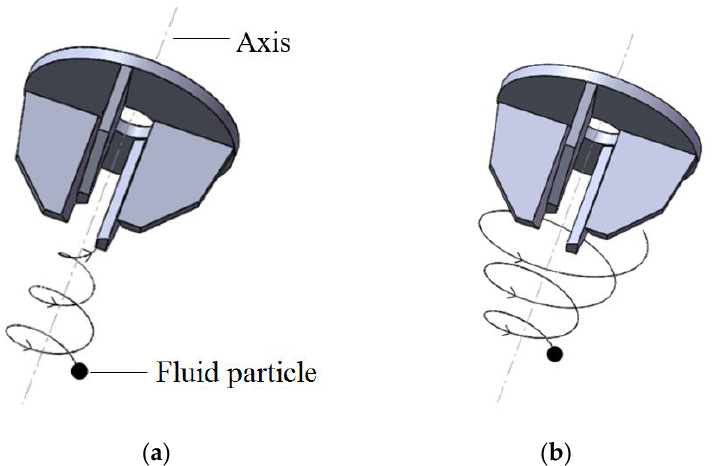
Figure 1. Motion trajectory of fluid particles below the impeller: ( a ) radial velocity toward the axis and ( b ) radial velocity away from the axis.